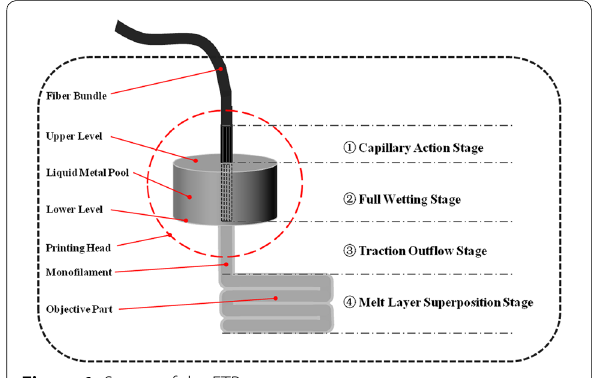
Figure 1 Stages of the FTP